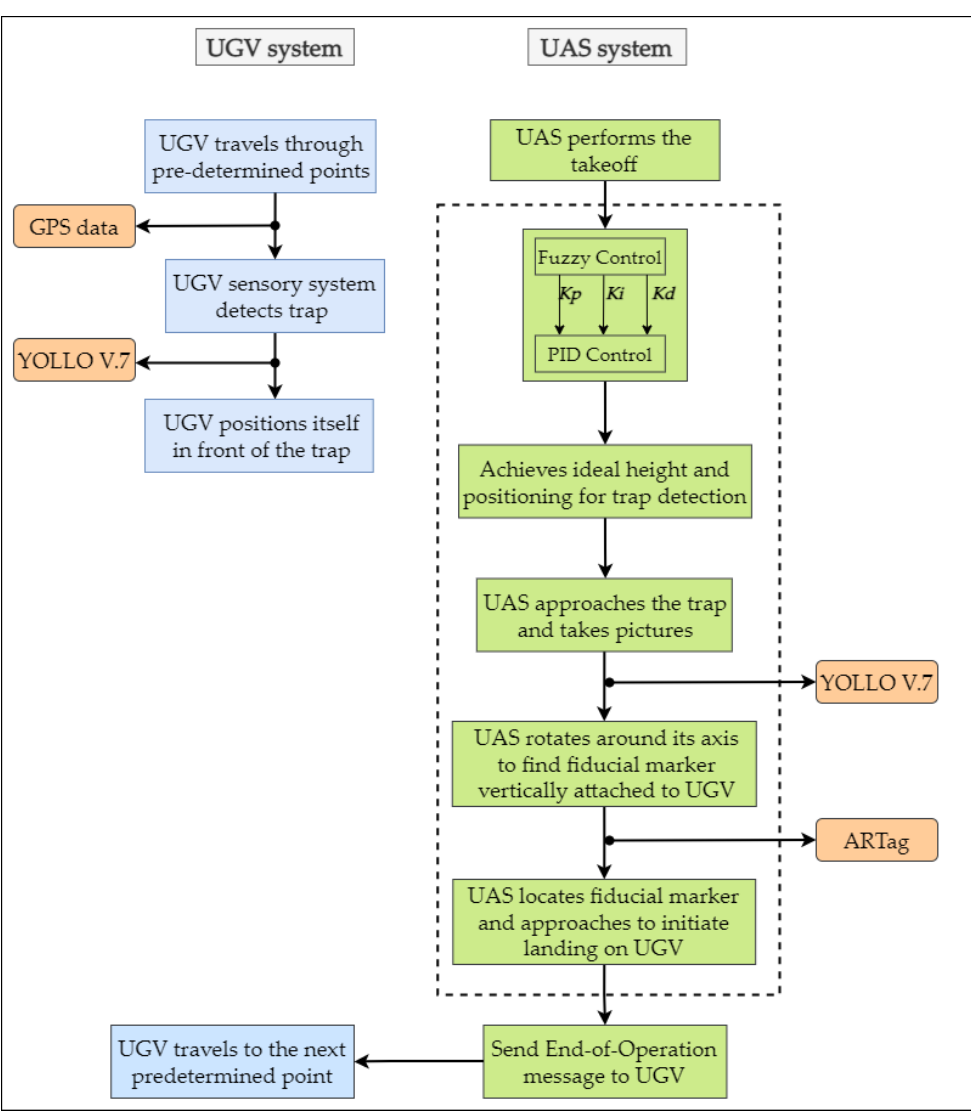
Figure 4. Flowchart of the proposed methodology